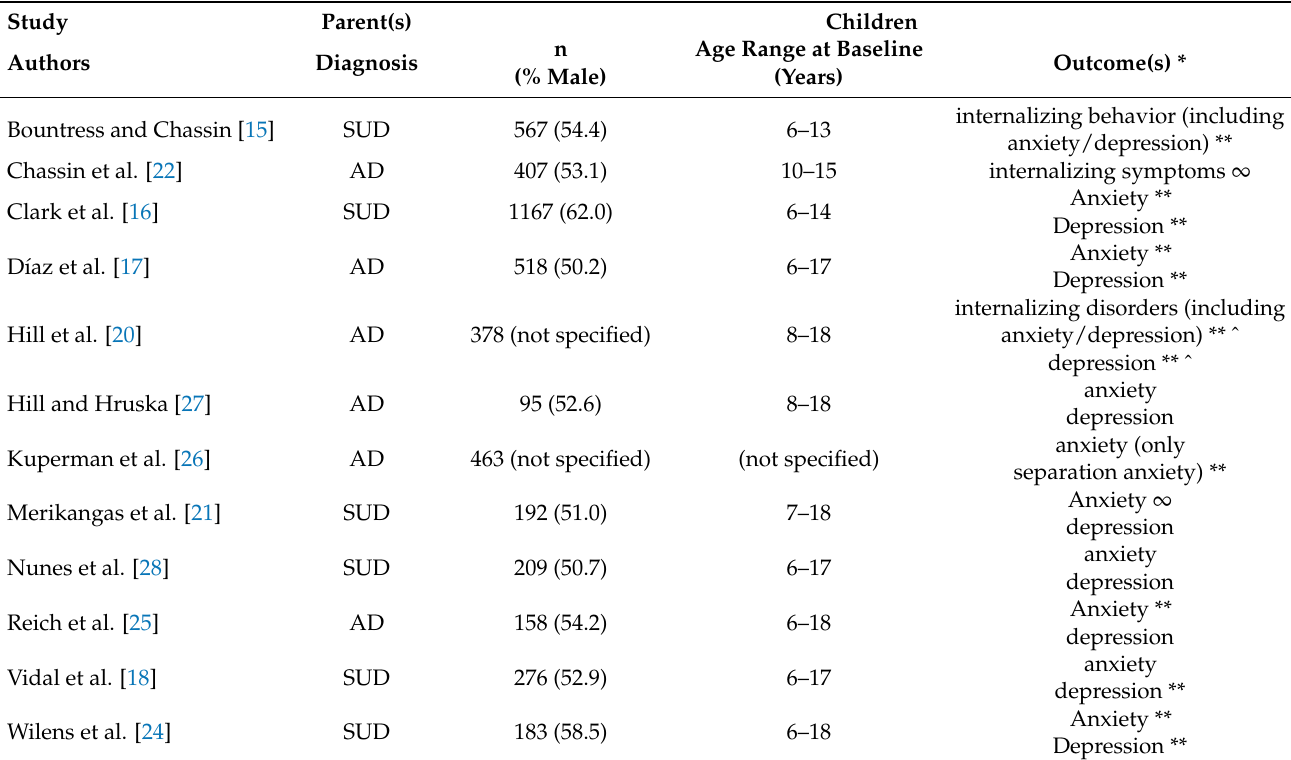
Table 1. Studies that have examined the relationship between residence with a parent with a substance use disorder (SUD) or alcohol disorder (AD) and anxiety and depression risk among their